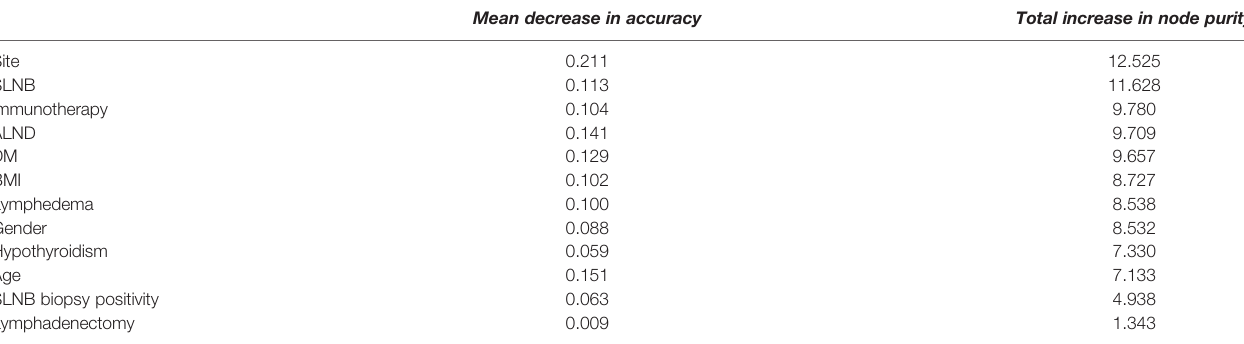
TABLE 2 | Variable importance in the entire cohort.